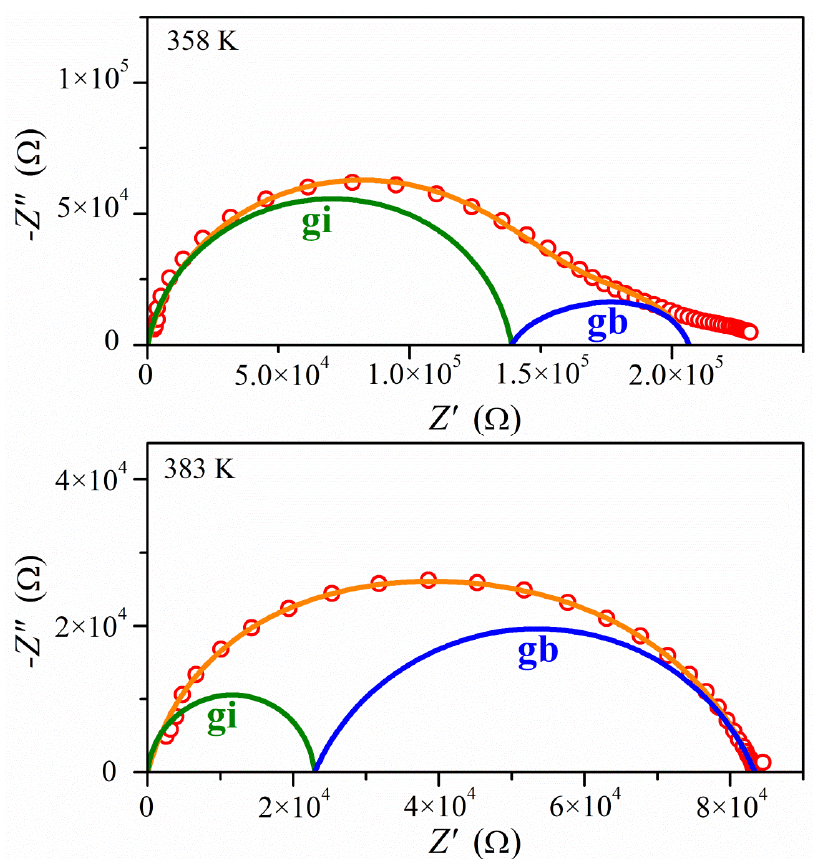
Figure 8. Complex impedance plots Z”(Z’) of the impedance for PyrHem×H 2 O for two temperatures 358 and 383 K. Red points are the experimental data, while the lines are obtained from fitting to Equation (3): olive lines denote the contributions from the interior of the crystallites (gi), blue lines are due to the crystallite boundaries (gb), and orange lines represent fitting for all samples.